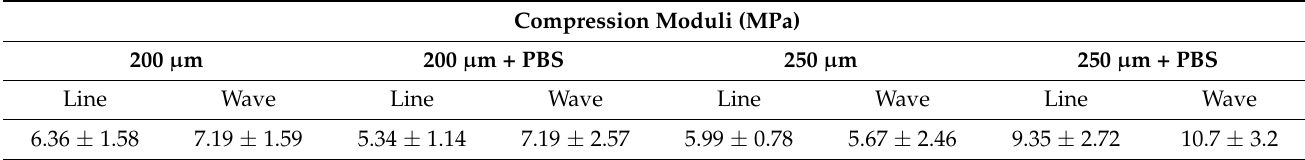
Table 2. Summary of the compression moduli for the different scaffolds ( n =